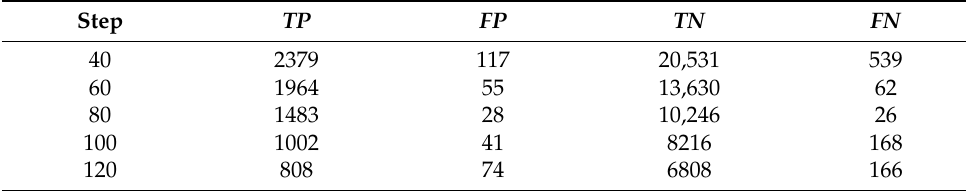
Table 7. Effect of step on TP , FP , TN , and FN .